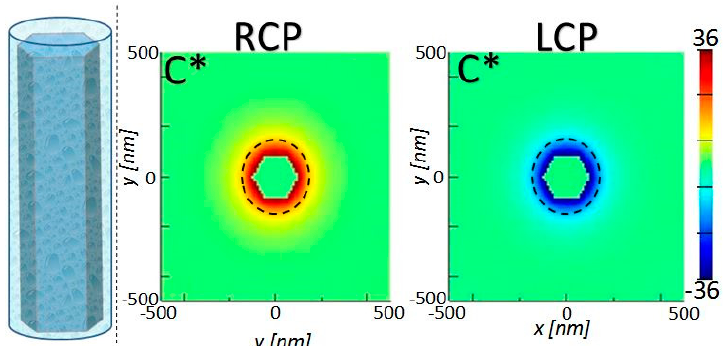
Figure 6. Left: sketch of the Si NW functionalization with bonded chiral substance for the improvement of enantioselectivity. Right: xy cross-section of C* distribution at the antinode of the NW with r = 50 nm, L = 1000 nm, and p = 500 nm (resonant wavelength at 542 nm) for RCP and LCP excitation. Dashed circles represent the volume of the enantiomers attached to the NW surface.